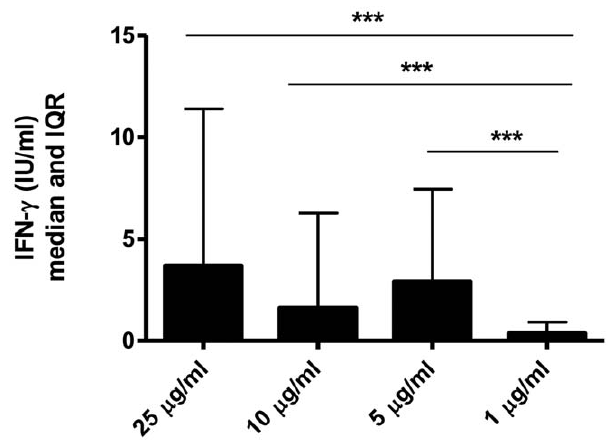
Figure 1. Concentration-dependent IFN- c response after invitro short-term whole blood stimulation with rHBHAms in subjects with LTBI. Whole blood from 10 subjects with LTBI was stimulated with or without rHBHAms at different concentrations (between 25 and 1 m g/ml). IFN- c response was evaluated after a short-term stimulation (1 day post- in vitro stimulation). A significant difference was found for the IFN- c response obtained between 25 and 5 m g/ml and that obtained at a concentration of 1 m g/ml.